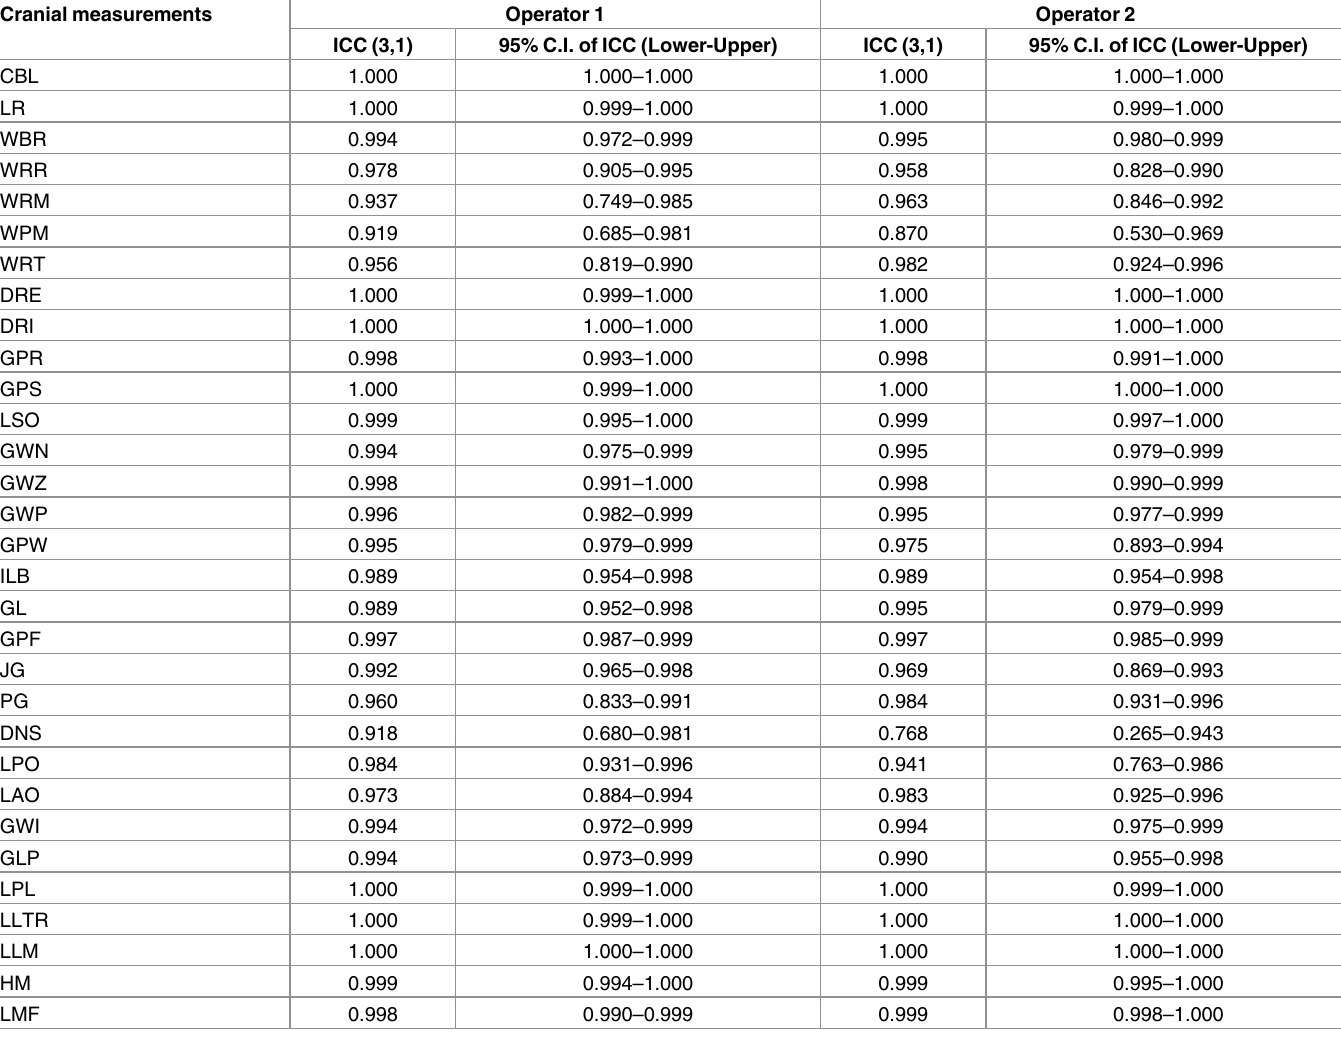
Table 3. Intra-operator (repeatability) variability of cetaceancranial measurements obtained by CT 3DVRI. Cranial